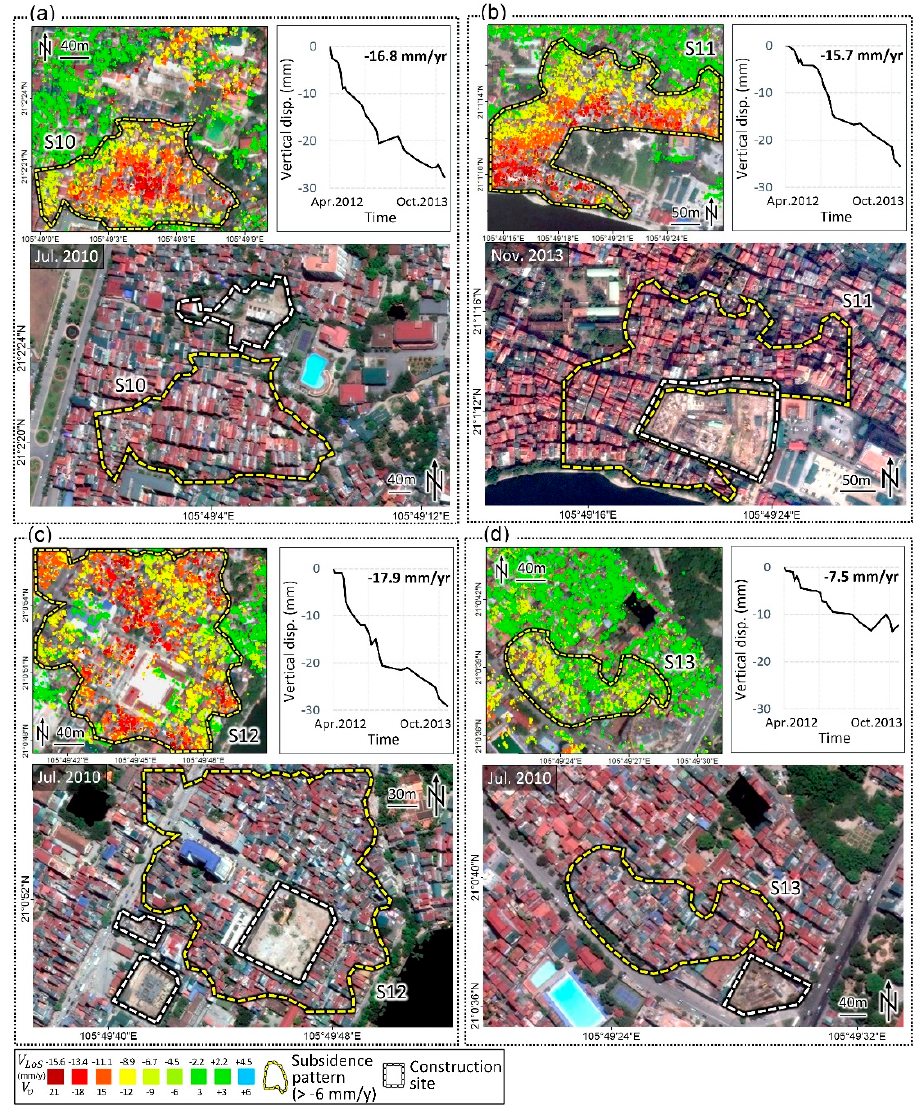
Figure 9. Average for April 2012–November 2013. LoS velocity map, temporal evolution chart and optical image represent location of subsidence pattern and construction sites in ( a ) Lieu Giai (S10); ( b ) Dong Da (S11); ( c ) Kim Hoa (S12) and ( d ) Thai Ha (S13). Characters in parentheses denote the label of subsidence patterns in Figure 4.